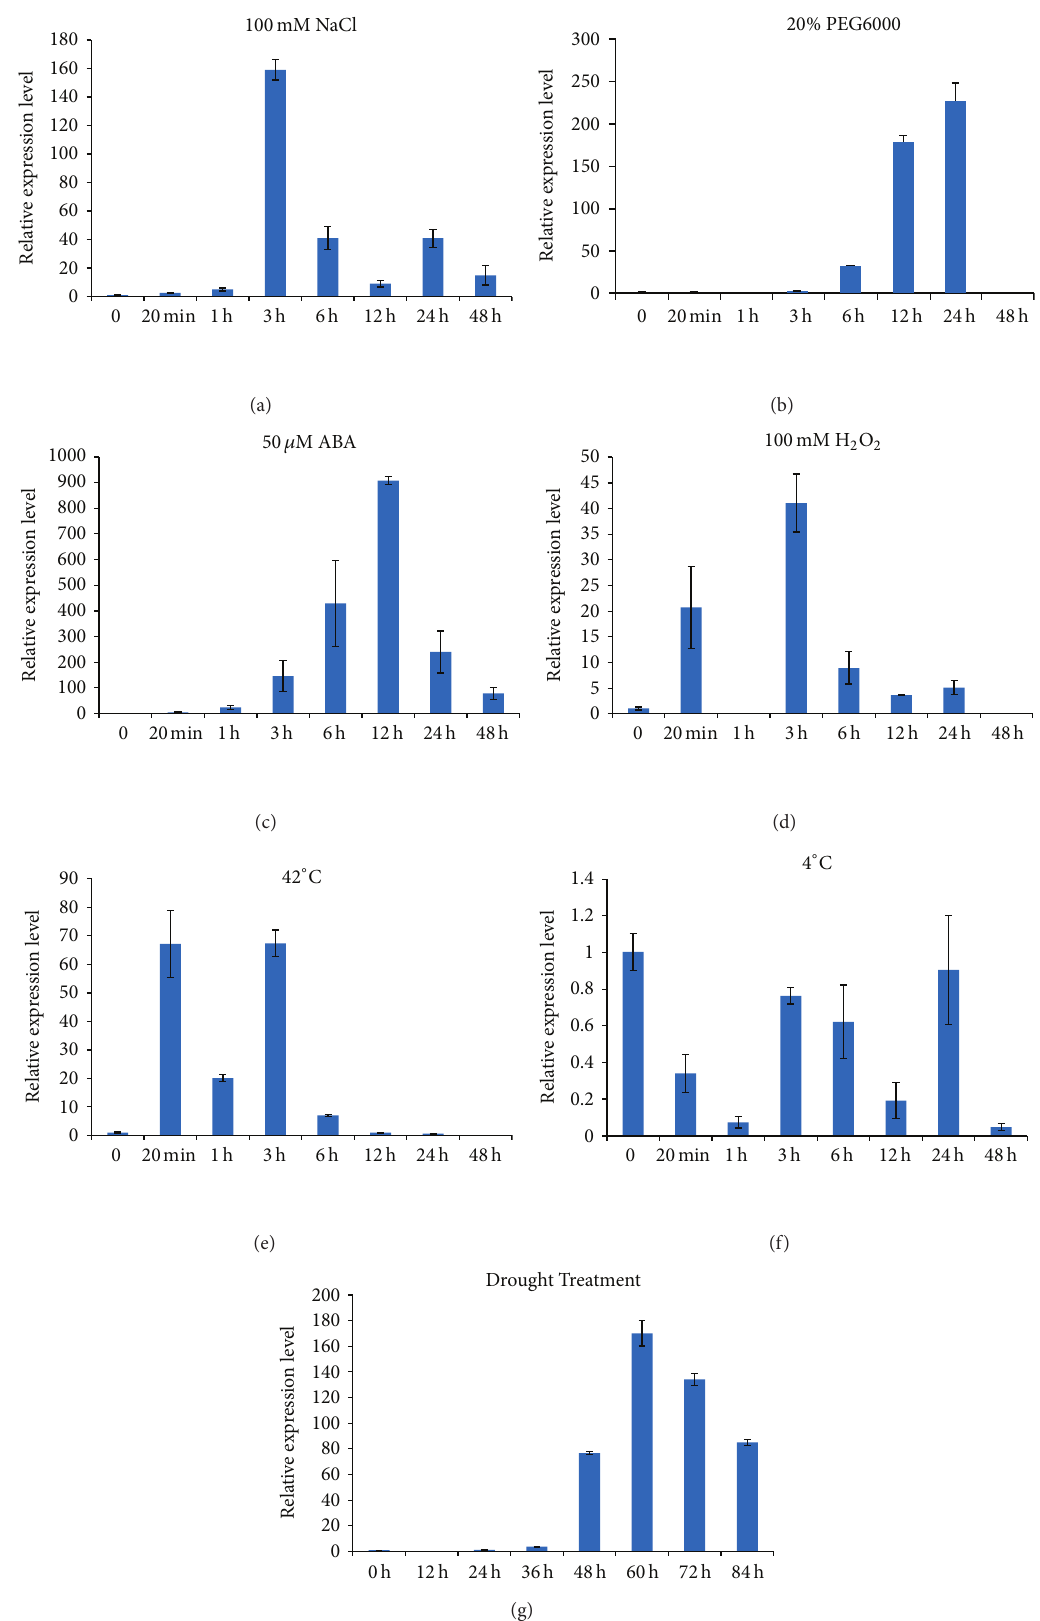
Figure 4: Expression change of OsSLI1 in rice seedlingsunder different treatments. (a) salt stress (100mM NaCl); (b) osmotic stress (20% PEG6000); (c) ABA treatment (50 𝜇 M ABA); (d) oxidative stress (100mM H 2 O 2 ); (e) high temperature (42 ∘ C); (f) low temperature(4 ∘ C); and (g) drought